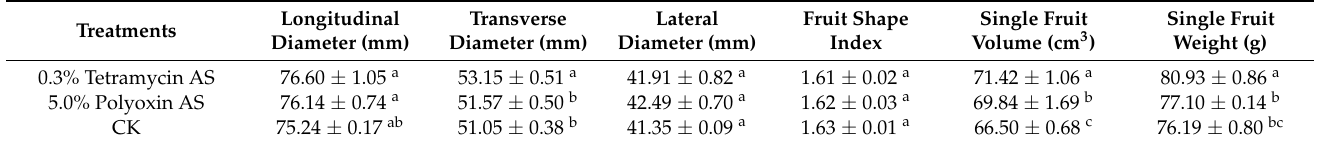
Table 4. The effects of tetramycin and polyoxin on the development of kiwifruit.